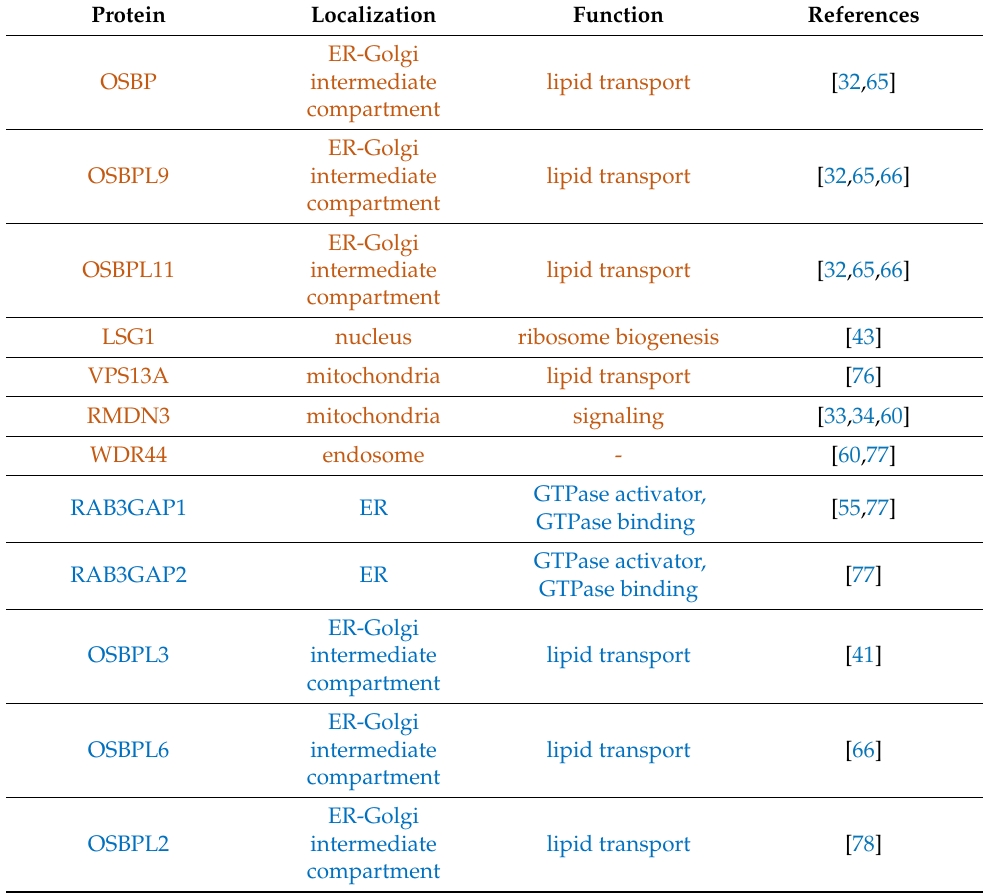
Table 1. Common interactors of VAPB as identified in three different